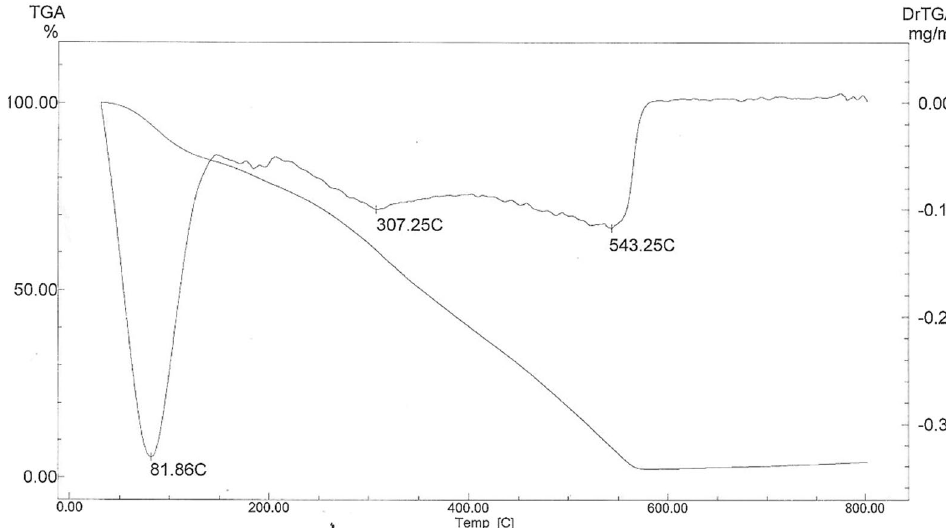
Fig. 4 TGA thermograms and derivative thermogravimetric (DTG) curves of the extracted sepia melanin powder (SM )